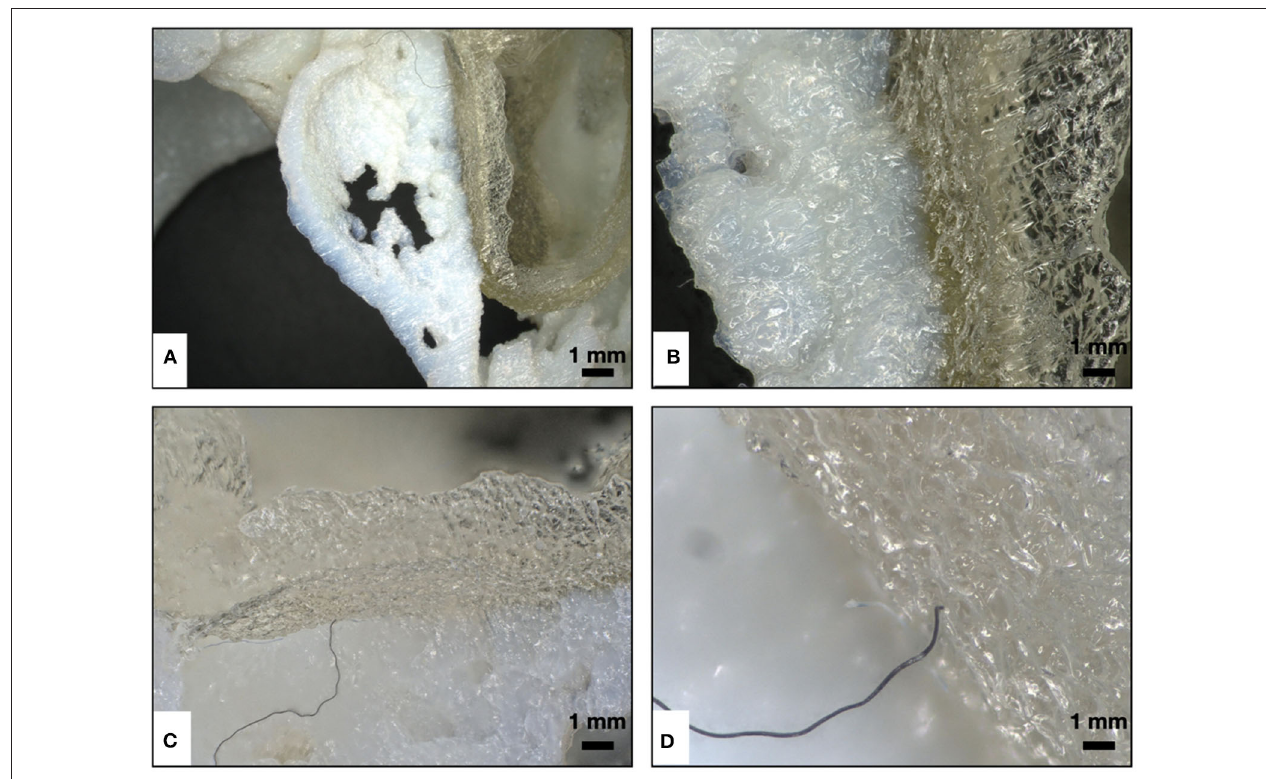
FIGURE 13 | Qualitative assessment of surface cleaning of the model signifying the removal of support material (SUP 706) using digital microscopy. (A,B) Image under × 20 magnification, showing both the hard and the soft model surfaces that were free of support material. (C,D) Image under × 20 magnification, showing the inclusion of a fiber in the printing material during the printing